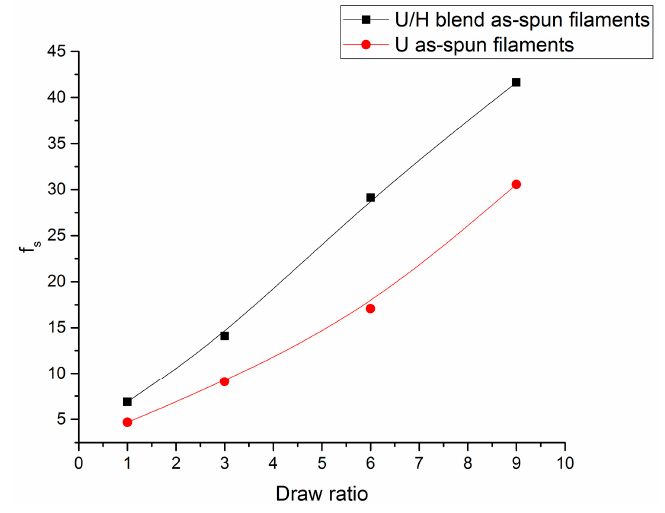
Figure 1. The orientation degree of the as-spun filament samples.